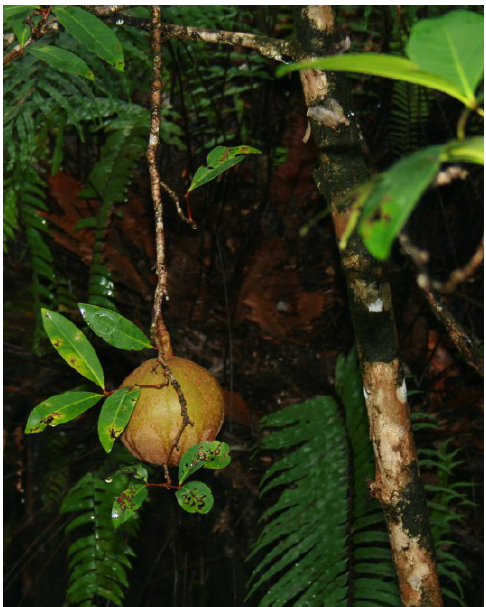
Figure 11. Xylocarpus granatum